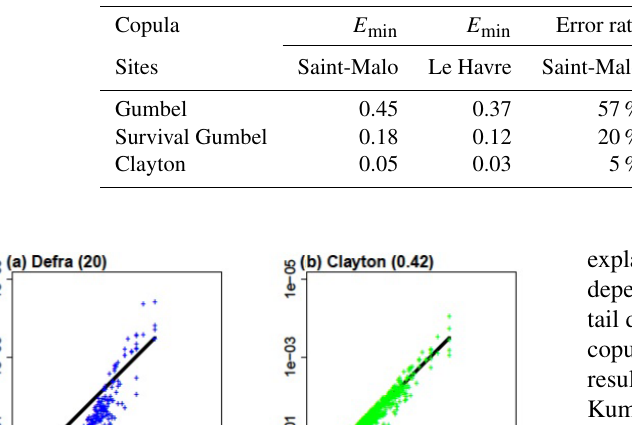
Table 3. E min , error rate and copula parameter for the different survival copulas in the ports of Le Havre and Saint-Malo: Clayton, Gumbel and survival Gumbel.